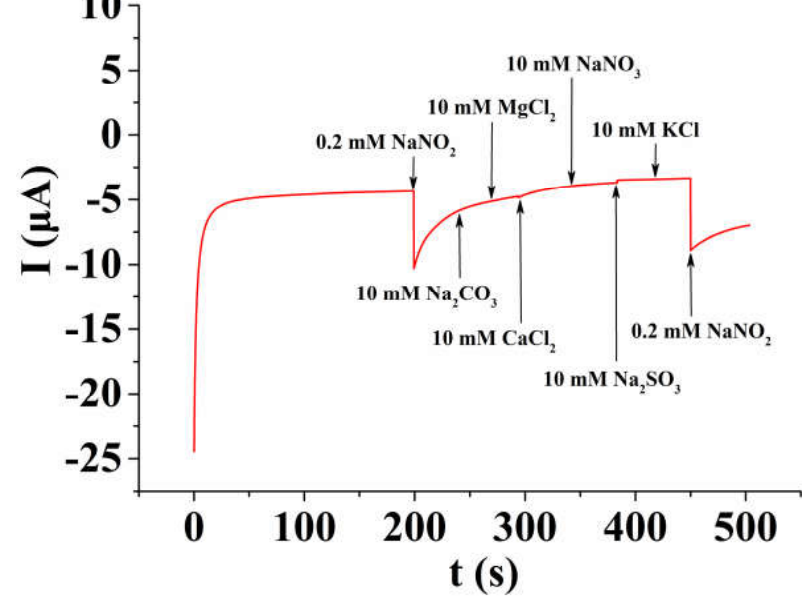
Figure 10. Amperometric responses of 0.2 mM nitrite and other possible coexisting interferents on PTP−AgNP/PGE in 0.1 M PB (pH = 4.0) with the operation potential of 0.9 V.